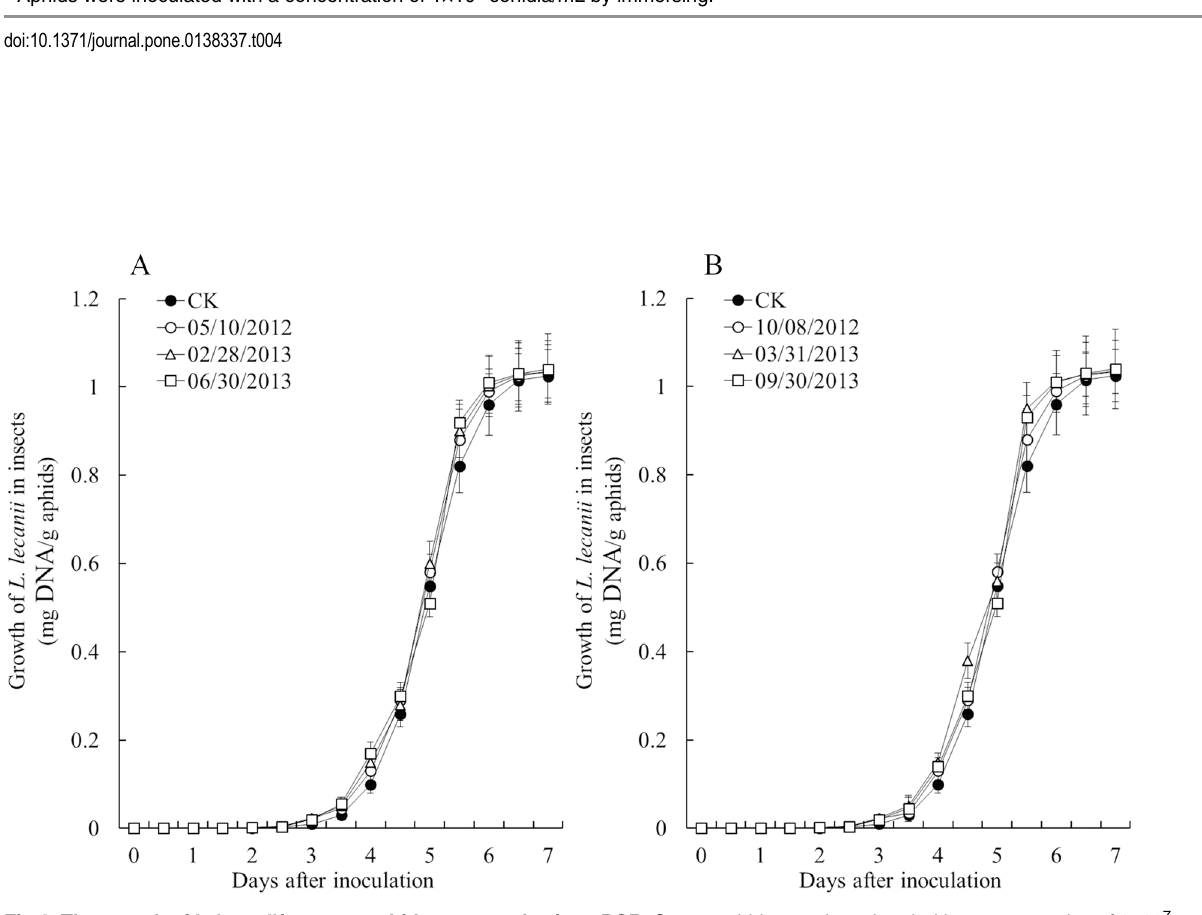
Fig 4. The growth of L . lecanii in cotton aphids measured using qPCR. Cotton aphids were inoculated with a concentration of 1×10 7 conidia/mL by